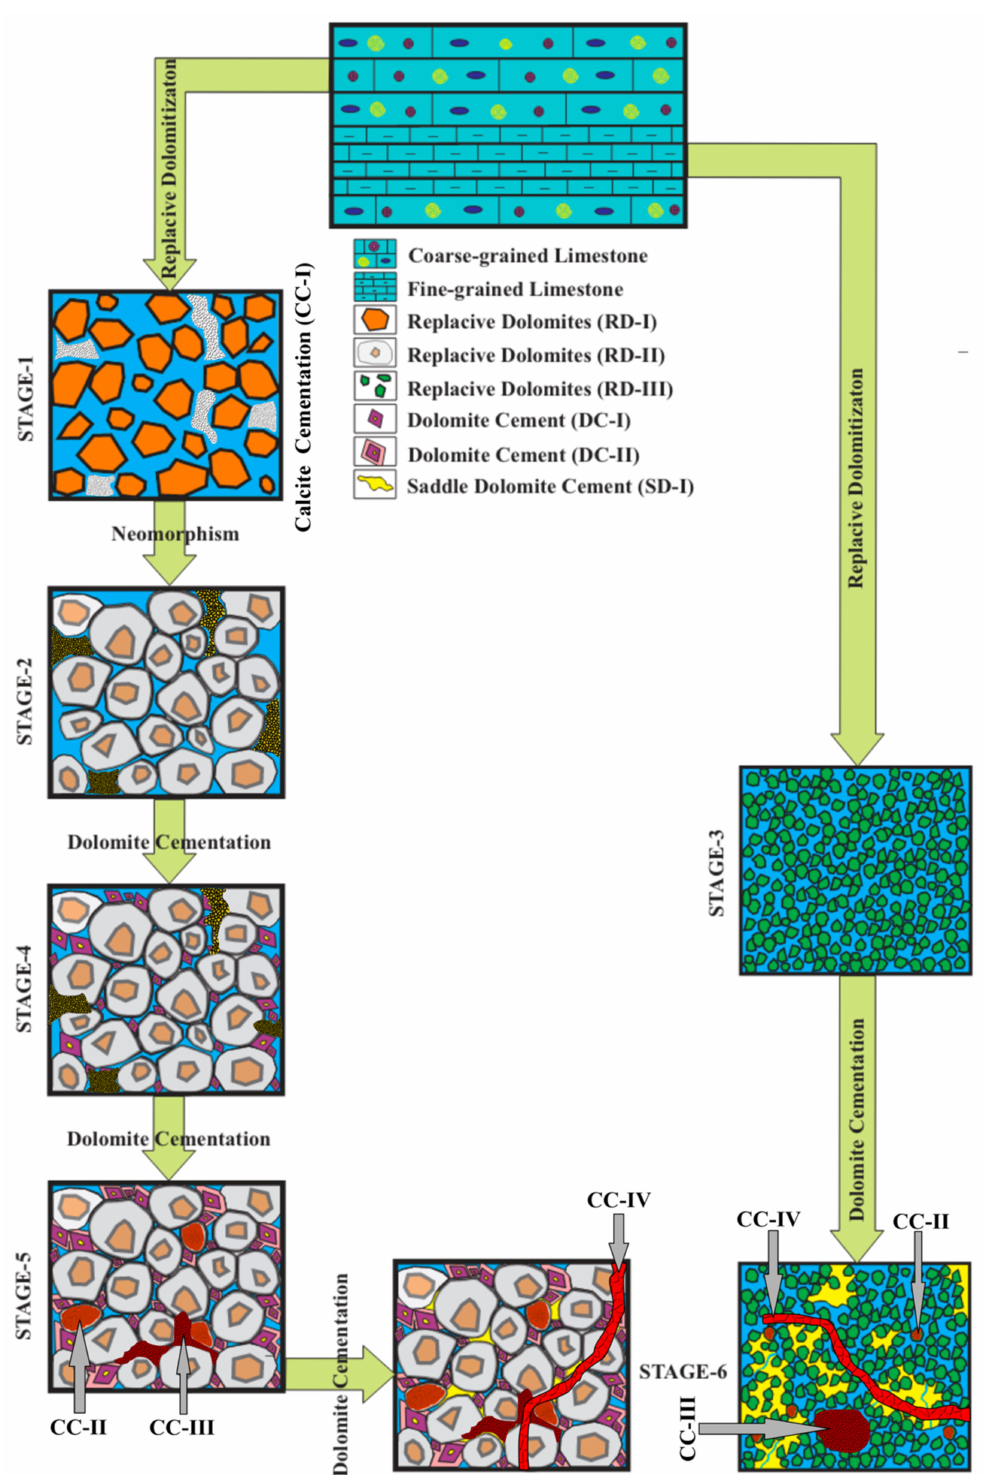
Figure 11. Conceptual model for the evolution and destruction of porosity as a result of different diagenetic